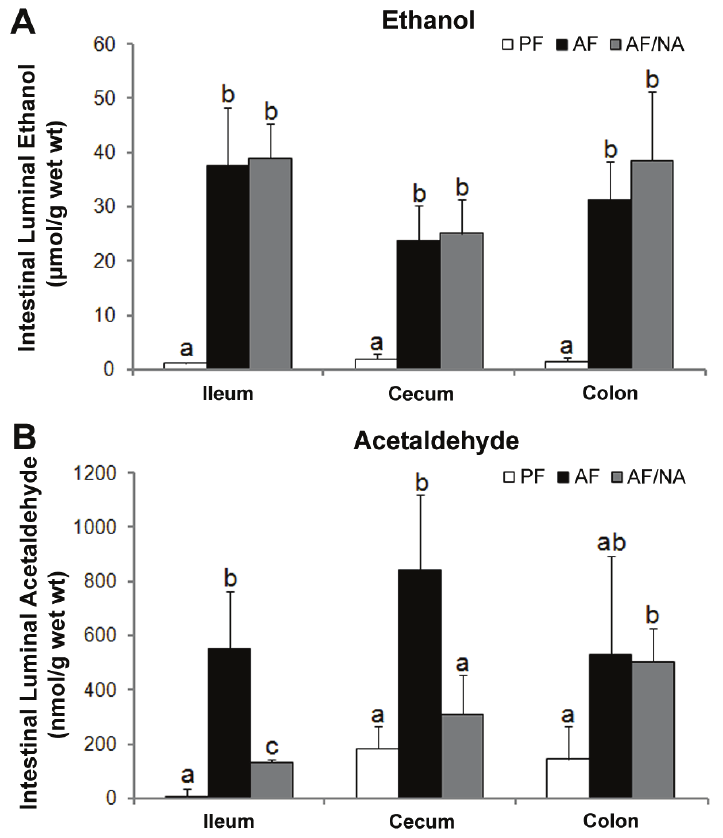
Figure 6. Intestinal luminal concentrations of ethanol ( A ) and acetaldehyde ( B ) in rats fed alcohol with or without nicotinic acid supplementation for 8 weeks. Ethanol and acetaldehyde in the ileal, cecal, and colonic lumen were measured by head-space GC-MS. Results are means ± SD ( n = 6–8). Significant differences ( p < 0.05, ANOVA) are identified by different letters. PF: pair-fed; AF: alcohol-fed; AF/NA: alcohol-fed with nicotinic acid